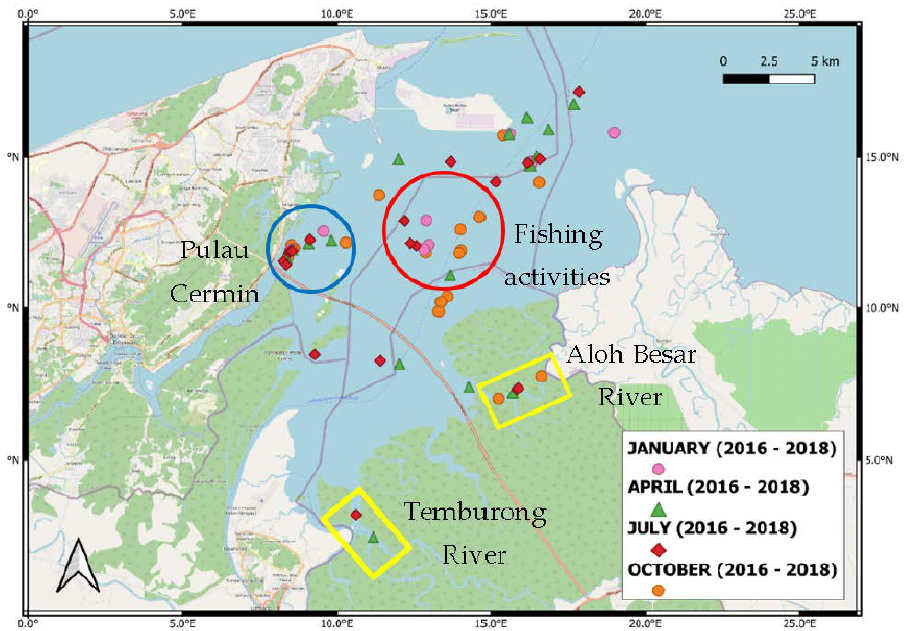
Figure 4. Overall sightings of Irrawaddy dolphins in the Bay of Brunei, Brunei Darussalam, according to months from 2016 to 2018.